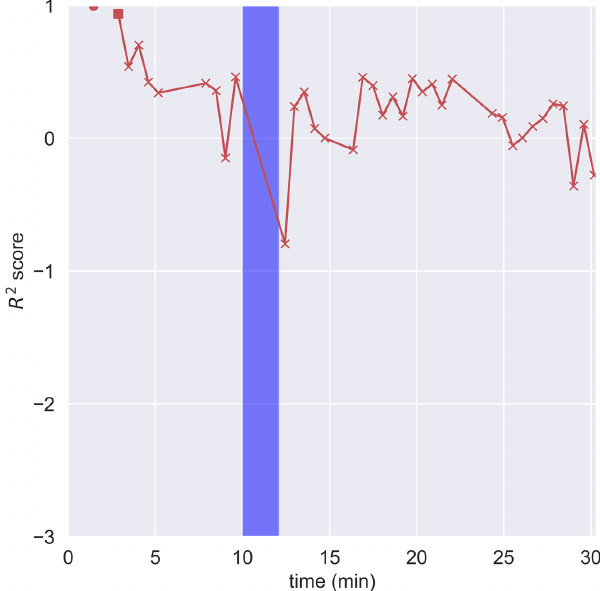
FIG. 1. Prediction performance of a neural network model at FERMI. The model uses several hundred features along the linac and FEL to predict the output intensity of the FERMI FEL. The R 2 score on the training set is shown as a circle, the score is 0.995. The score on the cross validation set is shown as a square, the score is 0.914. The x-marks show the R 2 score for the model as a function of time after the first training sample was taken. The samples are accumulated in batches of approximately 1000 and the score is computed for each batch. Before each batch is scored, any sample with any feature value greater than 5 standard deviations from the mean for that batch is removed. The shaded region beginning at approximately 10 minutes shows a period of time when Klystron #3 went in to fault and the accelerator was not